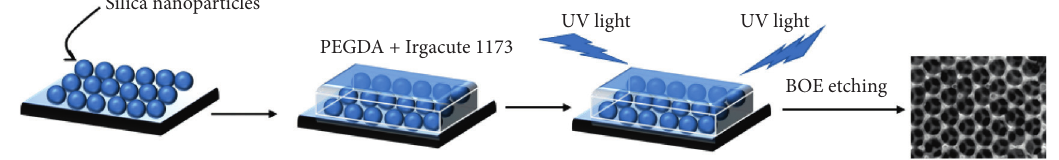
Scheme 1: Protocol for the fabrication of IOPCs.